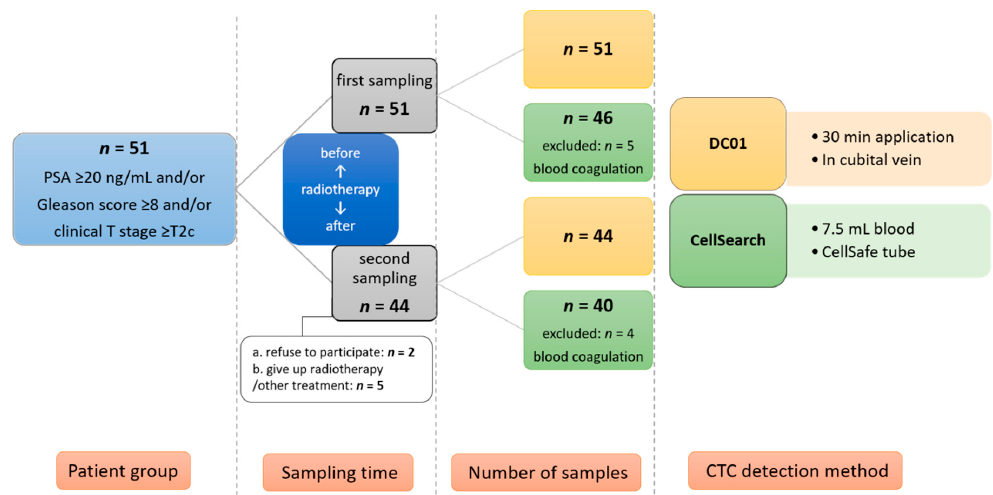
Figure 2. Illustration of study design and patient recruitment. CTC: circulating tumor cell.